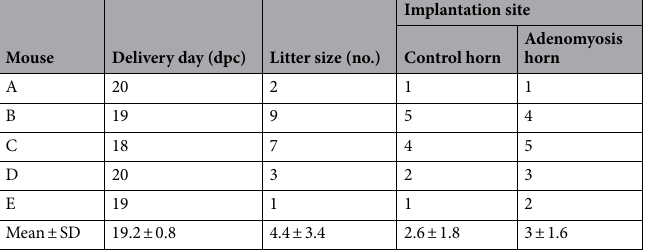
Mouse Delivery day (dpc) Litter size